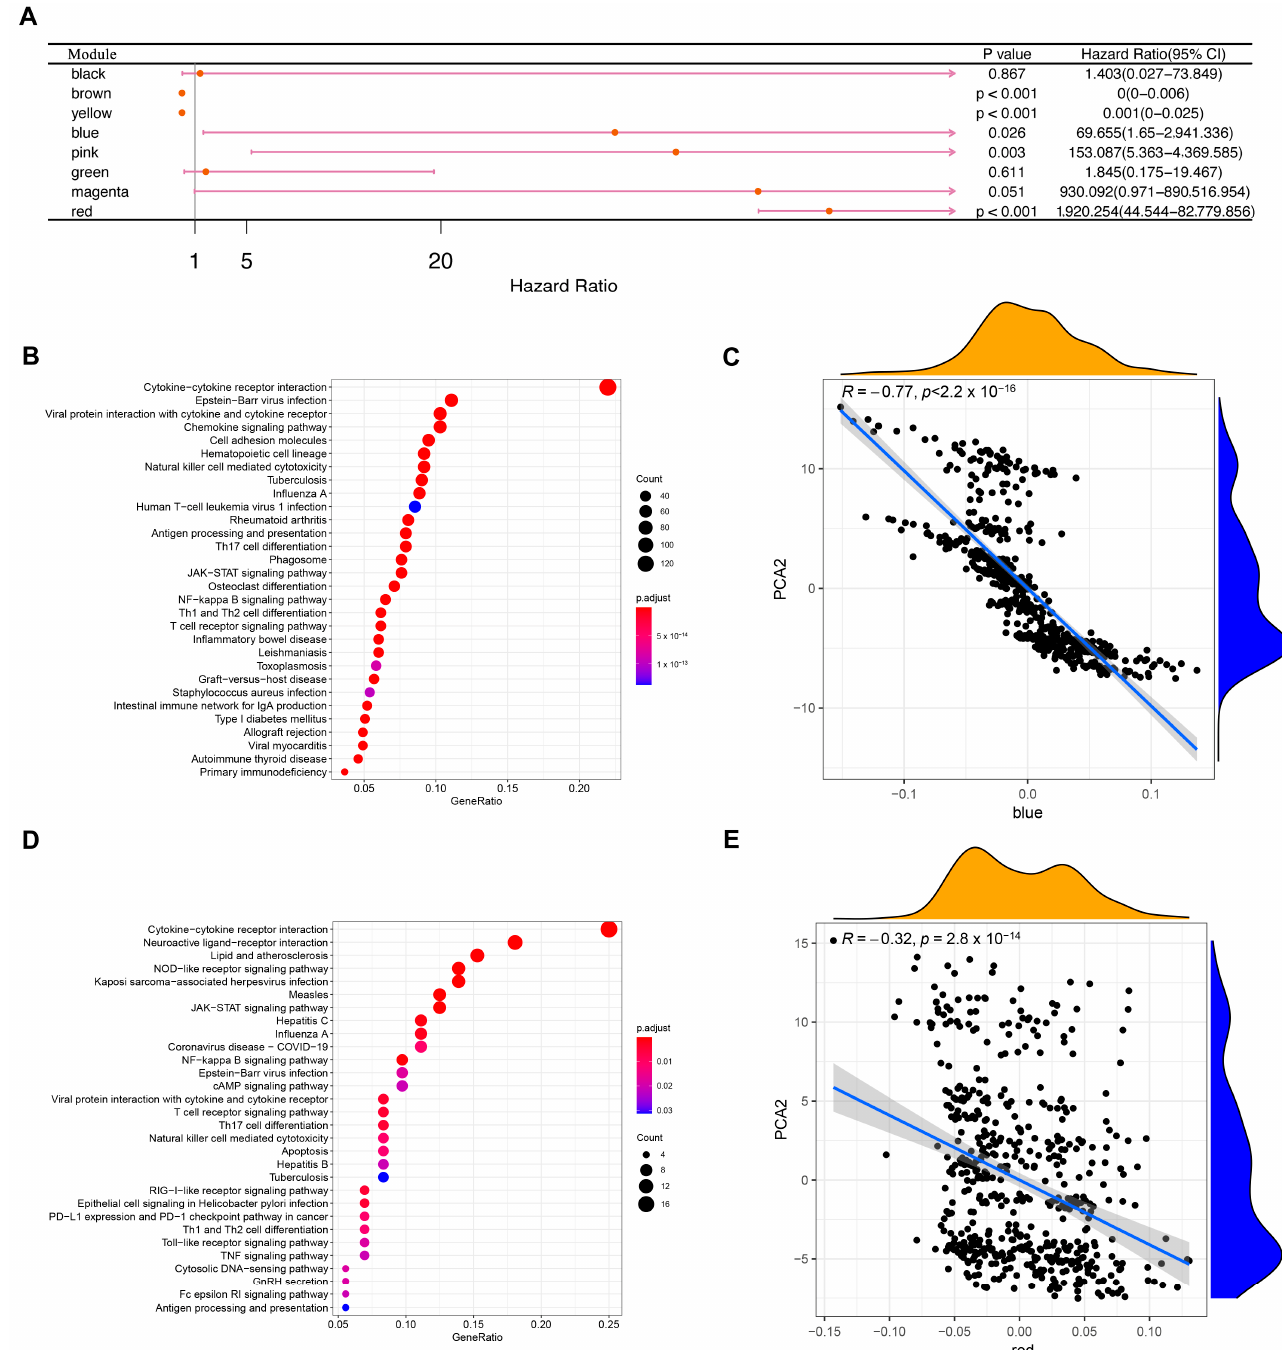
Figure 11. Identification of KIRC immune-related hub genes. ( A ) Single factor survival analysis of blue and red modules in KIRC. ( B ) A dot plot showing the top 30 biological processes in the blue module. ( C ) Correlation between feature vectors of the blue module and the second principal component in the immune landscape. ( D ) The red module shows the dot plot of the top 30 biological processes. ( E ) Correlation between red module feature vectors and the second principal component in the immune landscape. Kidney renal clear cell carcinoma (KIRC).